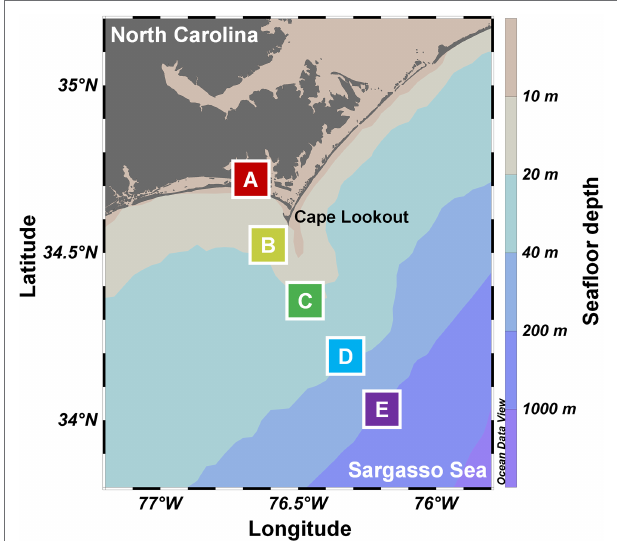
FIGURE 1 | Stations of the repeated sampling transects from July 2014 to August 2016. The transects begin at the estuarine Piver’s Island Coastal Observatory time-series site (station A), continuing 87 km offshore until the continental shelf break (station E). The color gradient for the background of the map indicates ocean